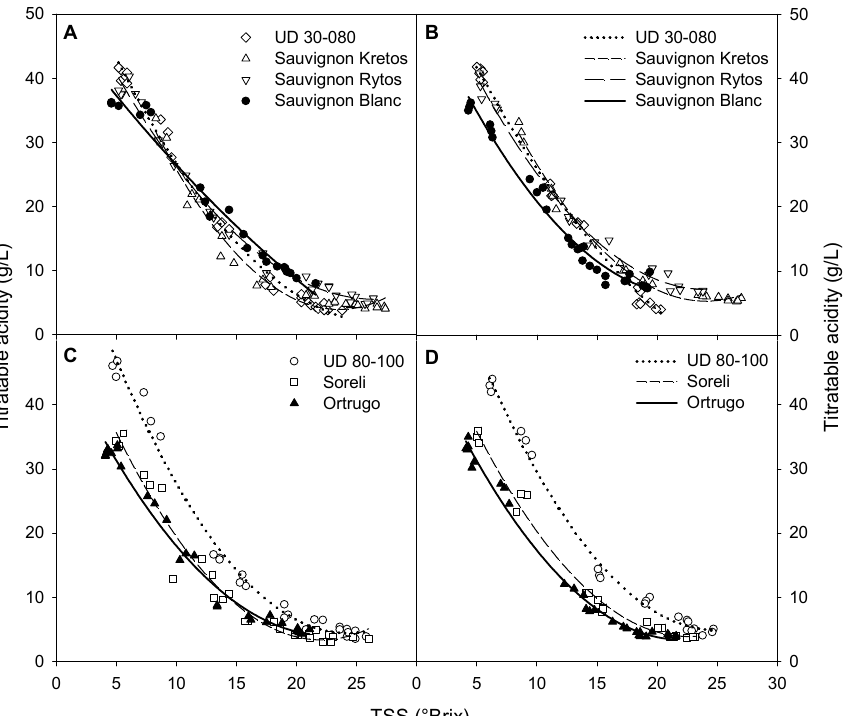
Figure 3. Seasonal variation of titratable acidity expressed as a function of total soluble solids (TSS) in 2019 ( A , C ), and 2020 ( B , D ), for 5 pathogens-resistant varieties (white symbols) and 2 reference V. vinifera cultivars (black symbols). Data were fit to the following equations: UD 30–080 2019 y = 70.07